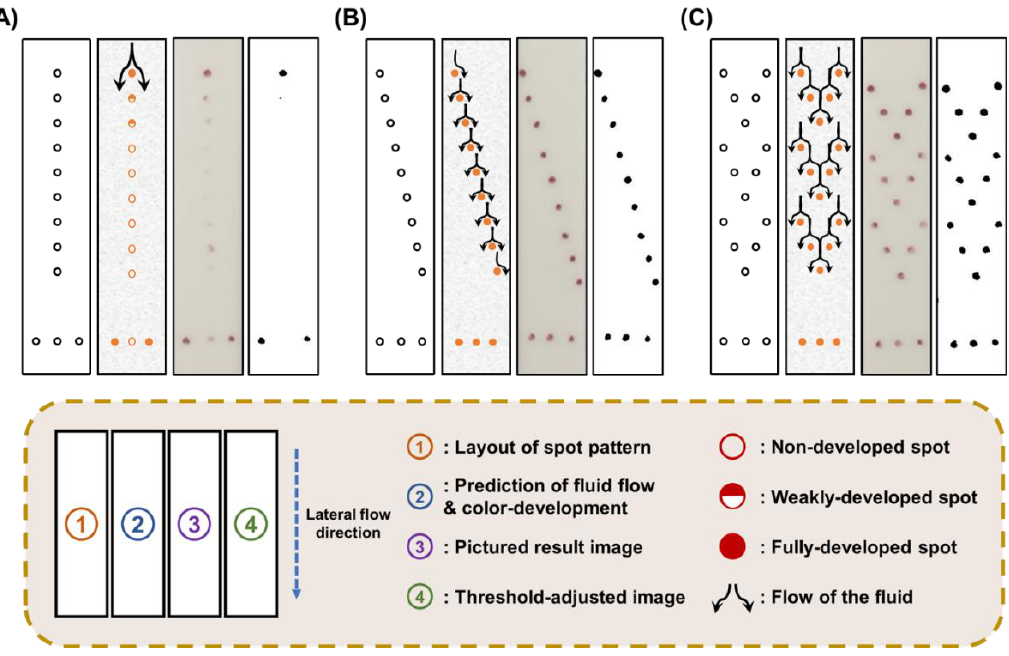
Figure 2. Examinations of various pattern types to select the most effective spot arrangement. ( A ) A linear pattern comprising nine linearly arranged spots. ( B ) A diagonal pattern comprising nine diagonally arranged spots. ( C ) A herringbone pattern comprising 15 spots arranged in a herringbone formation with five spots per unit.